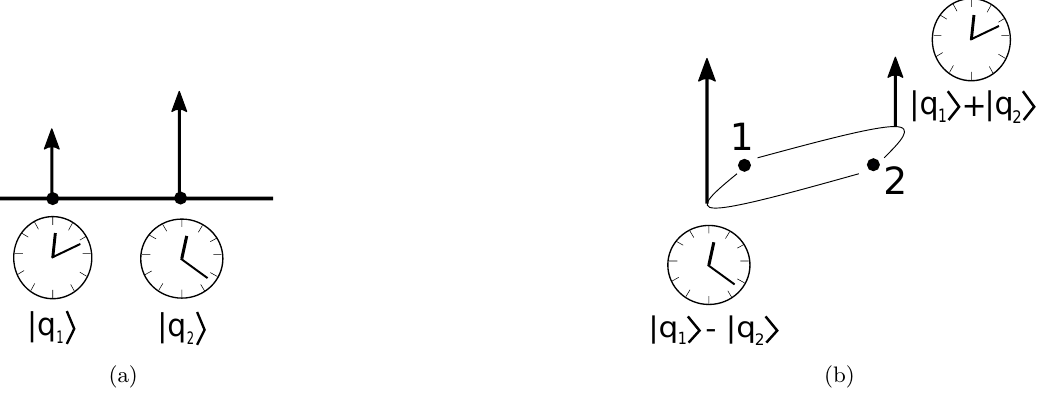
(cid:12) (cid:12) (cid:11) (cid:11) and (cid:12) q 1 (cid:12) q 2